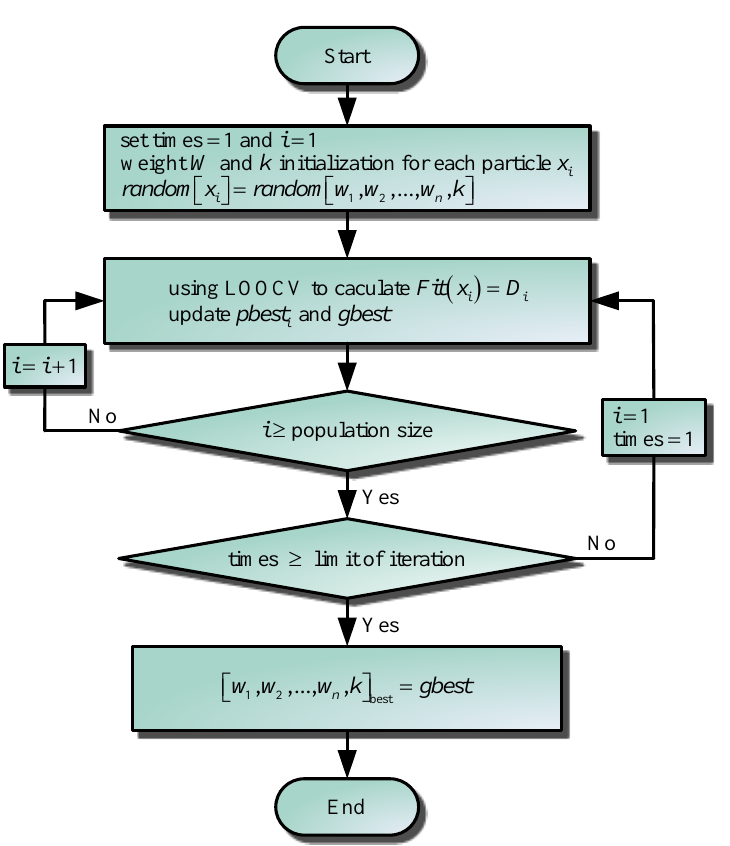
Figure 4. Flowchart of particle swarm with WKNN (PWKNN).